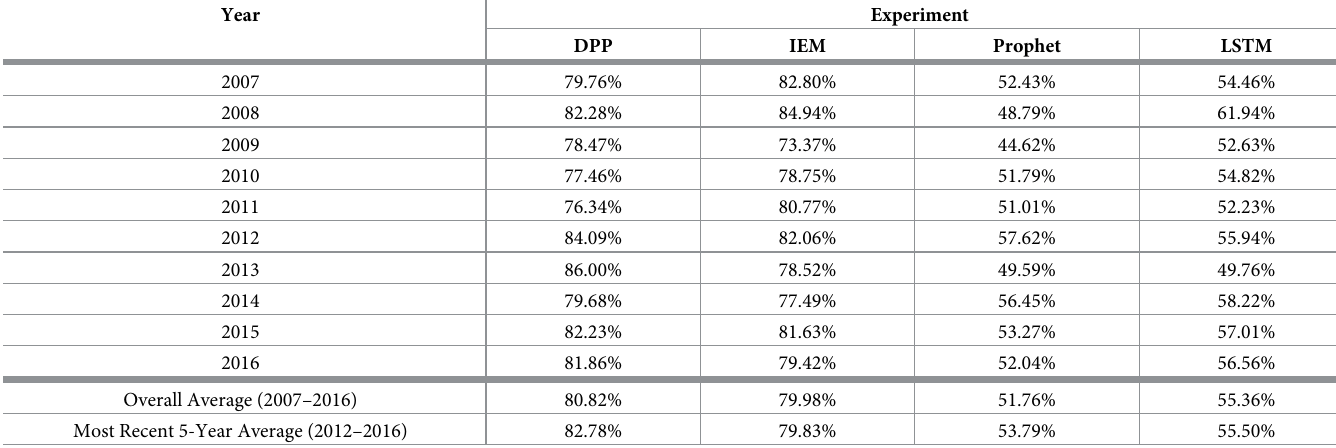
Table 1. Accuracy comparison for each year (TX dataset).